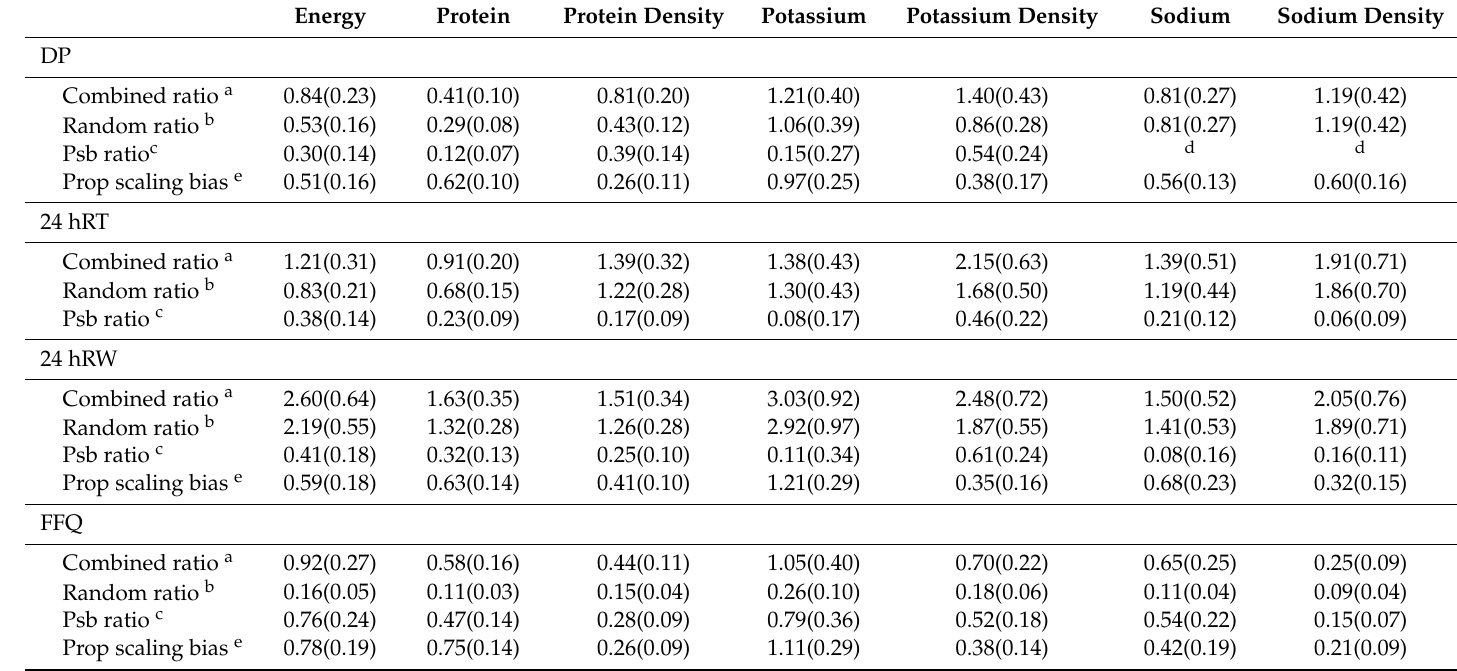
Table 4. Error ratios and proportional scaling biases for energy, protein, potassium, sodium, and their nutrient densities for the DP, 24 hRT, 24 hRW, and FFQ with the biomarker as the reference method